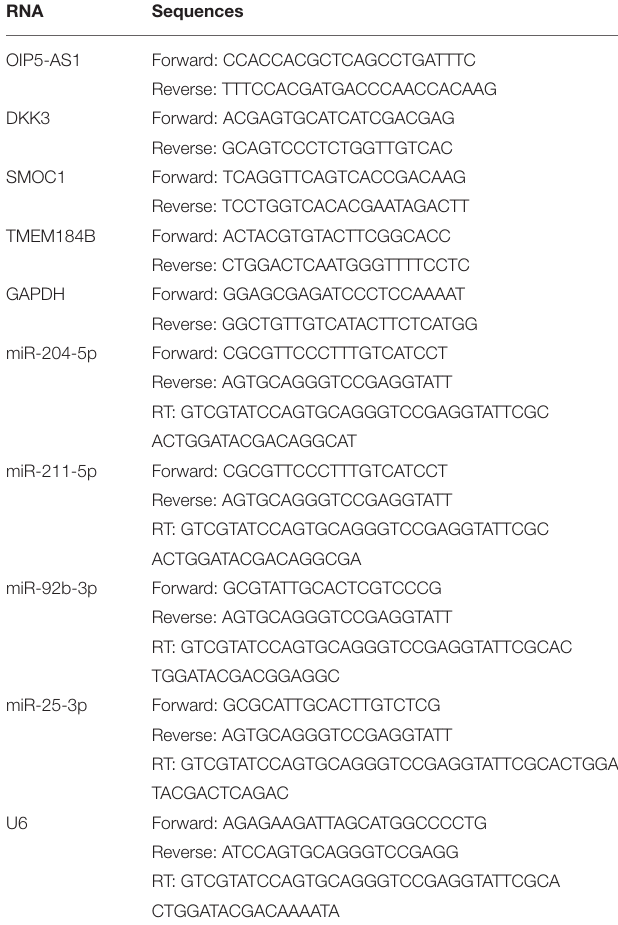
TABLE 1 | RNA primer sequences for quantitative real-time PCR.